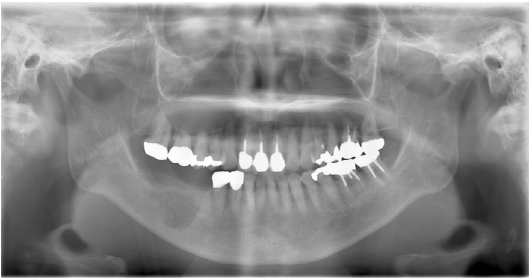
Fig. 2 Preoperative panoramic radiography. An ill-defined radiolucent lesion extending from the mesial aspect of #45 to the equivalent of #47. The mandibular canal was